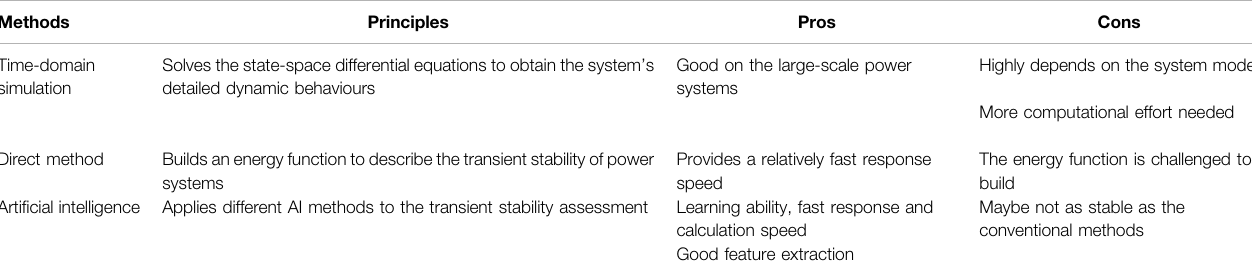
TABLE 1 | Pros and cons of difference AI methods.